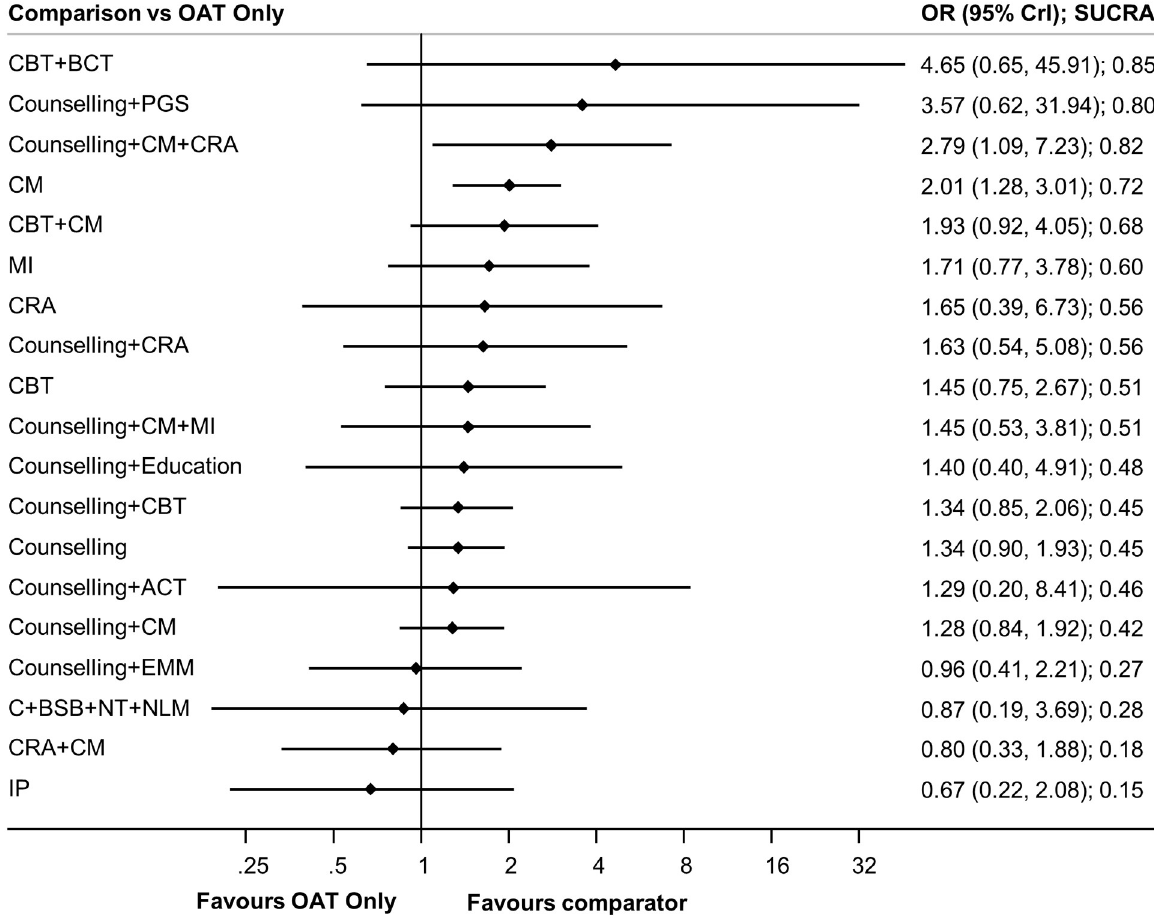
Fig 5. Forest plots of treatment retention. Forest plots of psychosocial treatments versus the reference group, OAT only, is